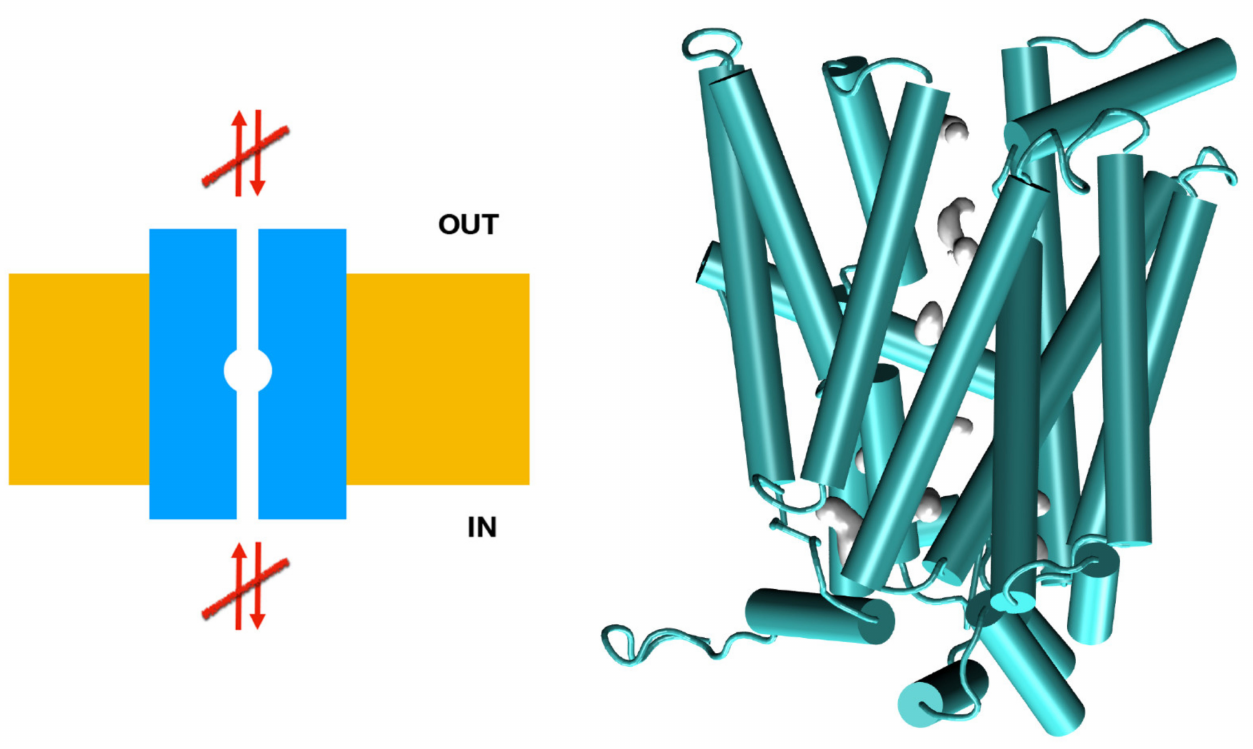
Figure 2. Mechanistic interpretation of the effects of the M126V mutation of SLC2A9b . The M126V model suggests that this mutation renders the vestibular regions unavailable. Left: schematic representation of the channel (in blue), membrane (yellow), and flow (arrows). Right: a snapshot of the M126V model during an MD trajectory, in cartoon representation in green. Internal space is represented by showing the solvent’s accessible surface in